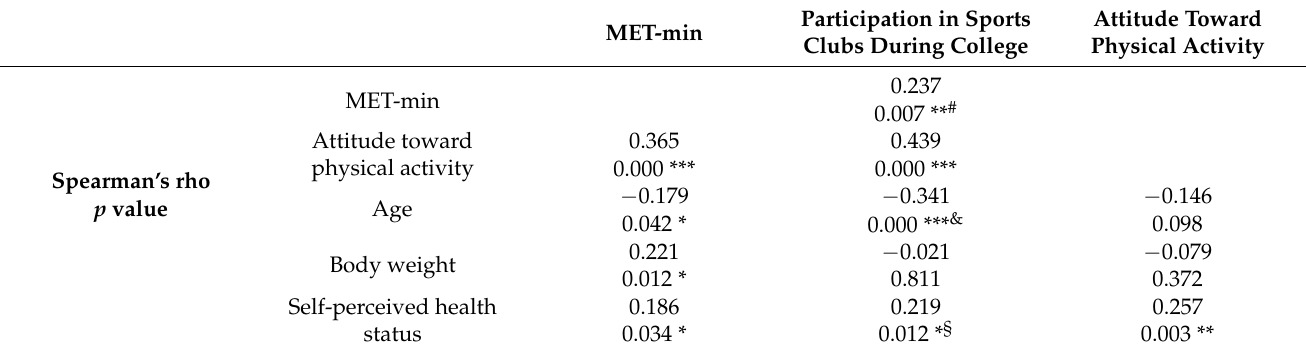
Table 4. Summary of correlation between physical activity levels and variables.